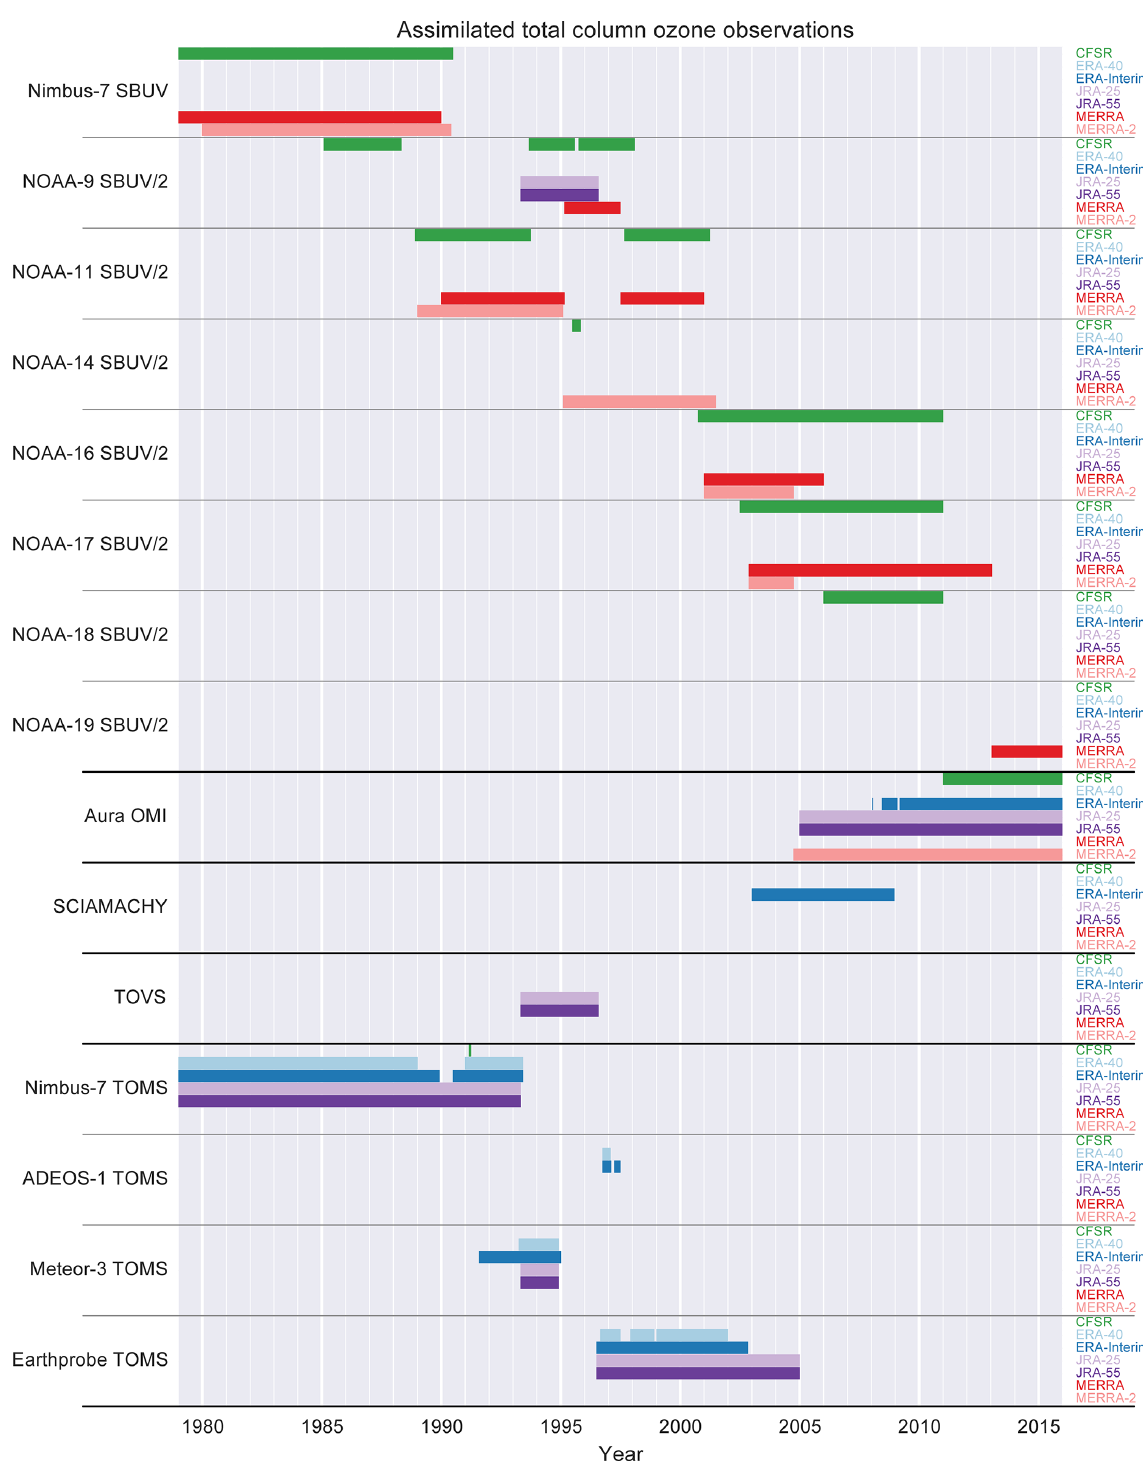
Figure 1. Total column ozone data by instrument as assimilated by the different